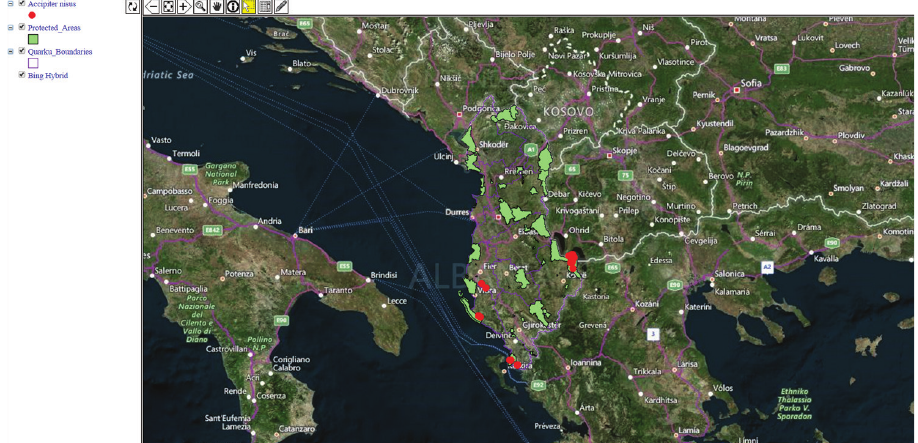
Figure 3. BioNNAWebGIS